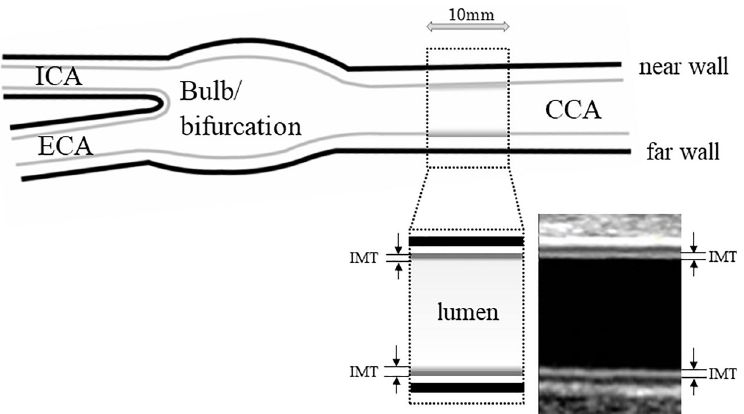
Fig 3. Measurement of intima-media thickness (IMT) in an ultrasonic image. CCA: common carotid artery, ICA: Internal carotid artery, ECA: External carotid artery.